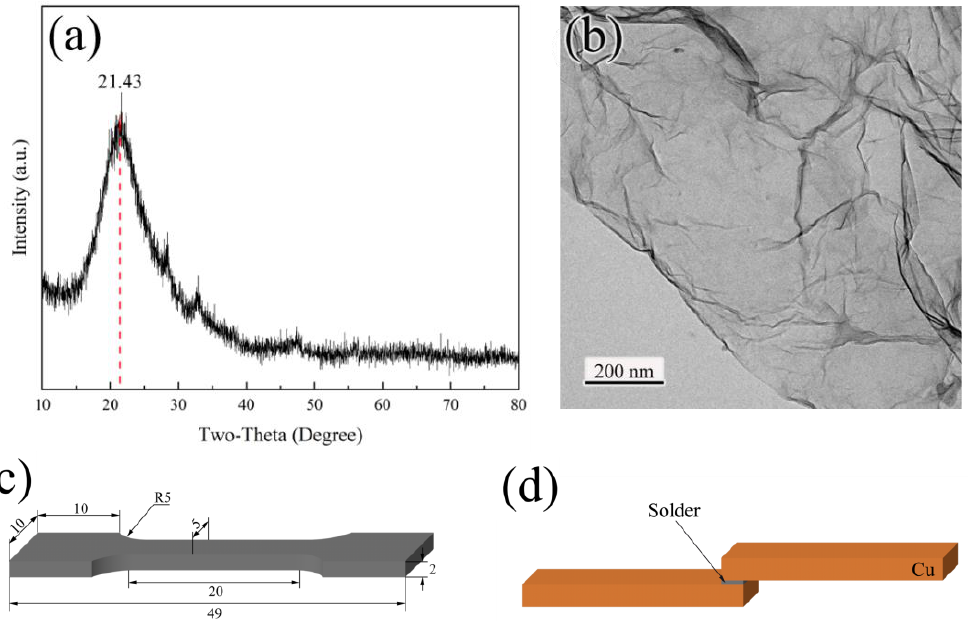
Figure 1. Raw materials GNSs: ( a ) XRD pattern, ( b ) TEM image, and the schematic of ( c ) tensile and ( d ) shear test samples.